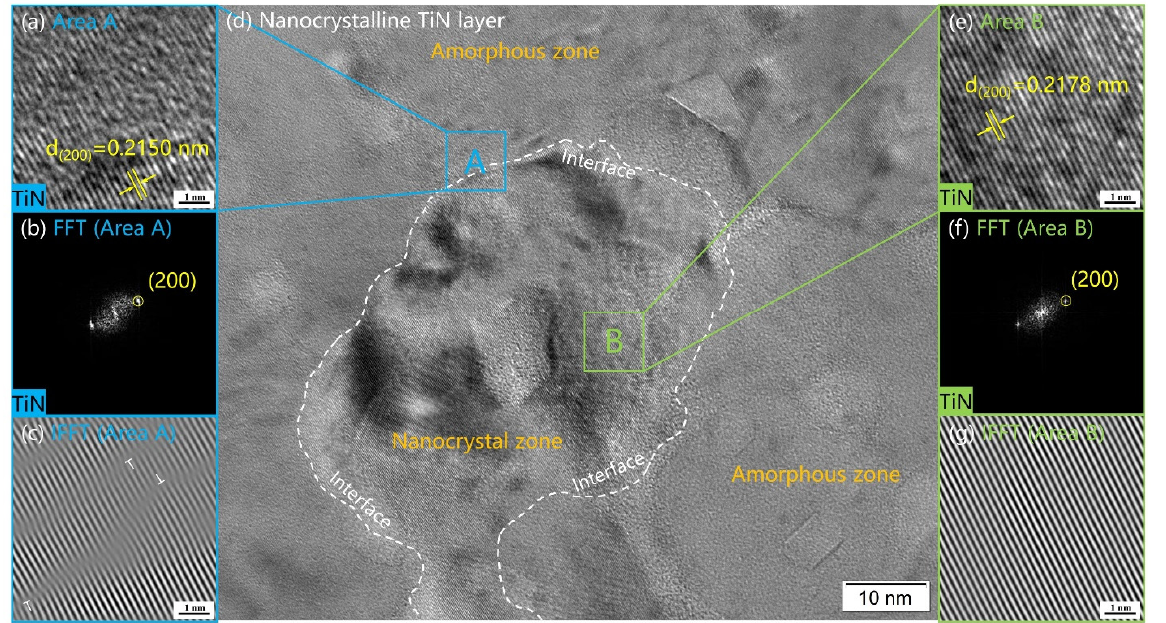
Figure 6. The HRTEM image ( d ) of surface layer nanocrystalline TiN. The most superficial layer was a nanocrystalline TiN layer. The TiN nanocrystals were surrounded by amorphous zone. The crystals were irregularly shaped and had a diameter of about 50~100 nm. The FFT ( b ) and IFFT ( c ) images of Area A ( a ). The FFT ( f ) and IFFT ( g ) images of Area B ( e ).